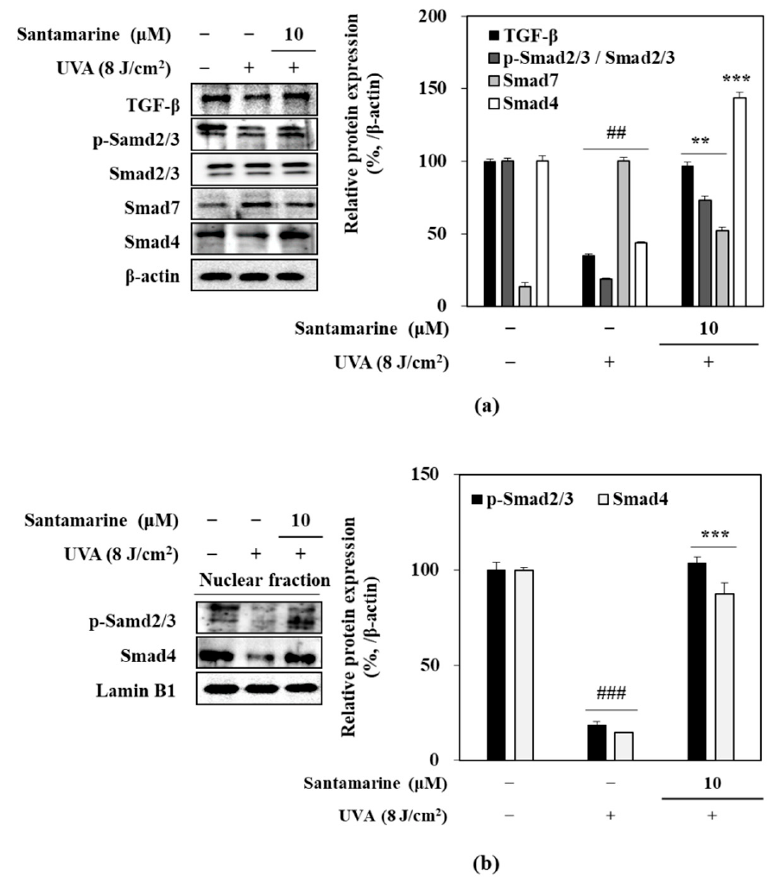
Figure 7. Effect of santamarine on TGF- β /Smad pathway activation. Total cell ( a ) and nuclear ( b ) levels of phosphorylated (p-) and total TGF- β /Smad signaling proteins were analyzed after 24 h treatment in UVA-irradiated (8 J/cm 2 ) HDFs via Western blot. β -actin and lamin B1 were used as loading controls. ** p < 0.01 and *** p < 0.001 vs. UVA-irradiated untreated control. ## p < 0.01 and ### p < 0.001 vs. non-irradiated control.